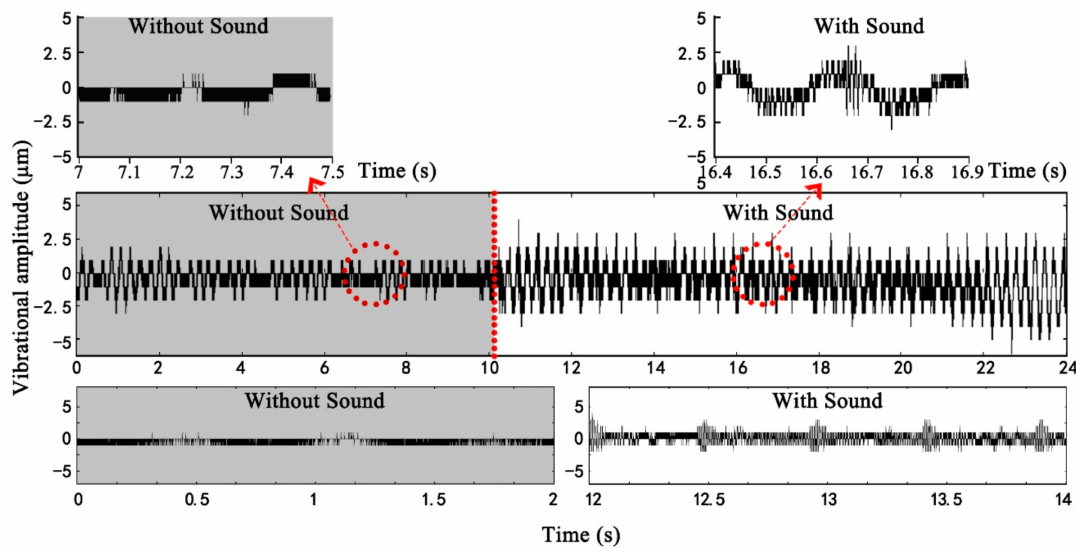
Figure 4. Data extraction